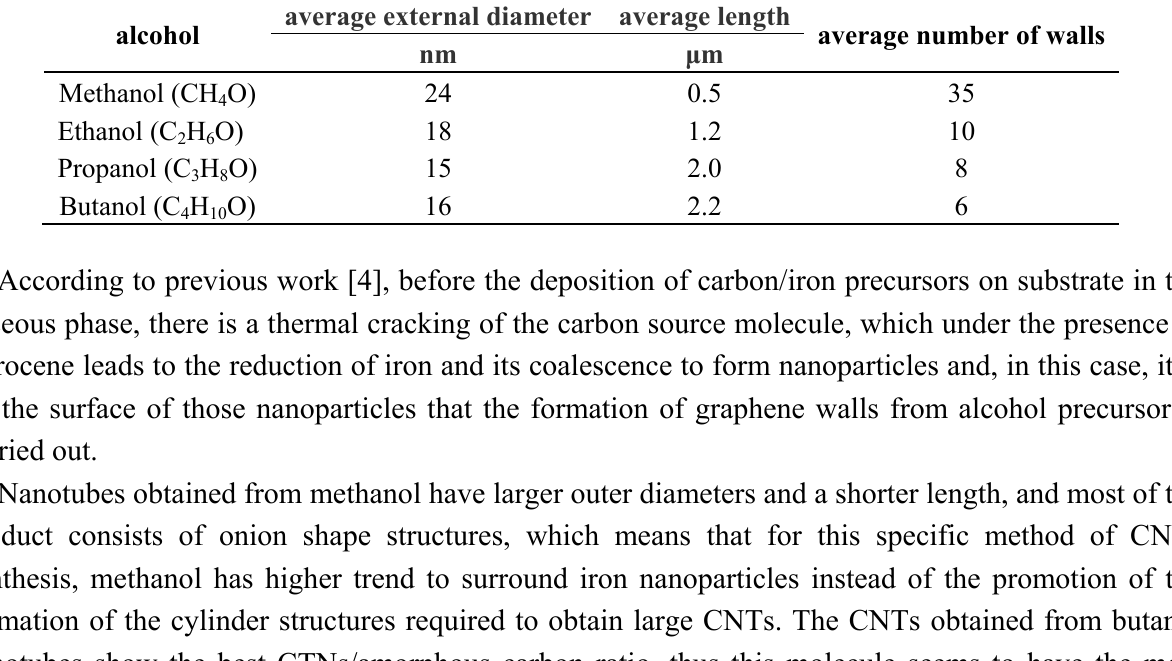
Table 1. Average external diameters, lengths and number of walls of carbon nanotubes.